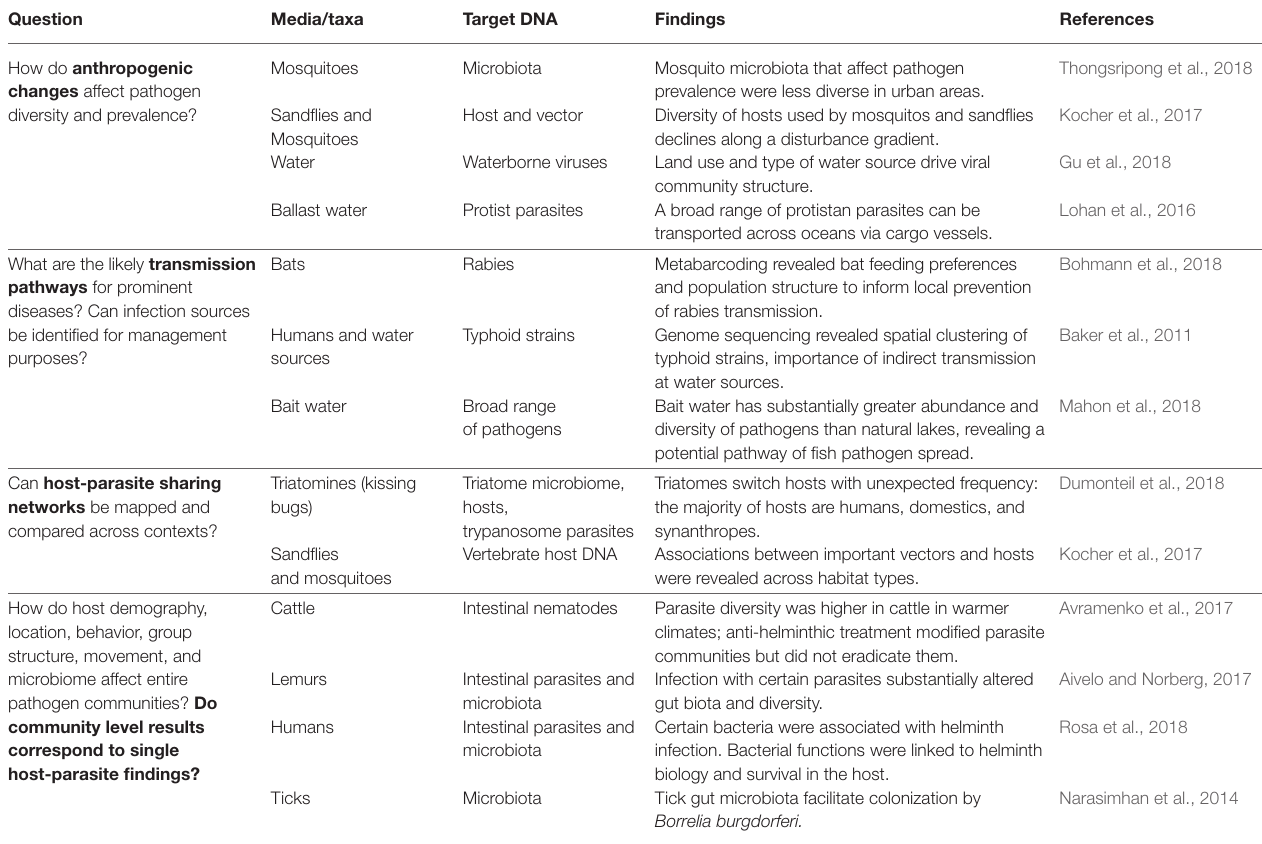
TABLE 1 | Questions in disease ecology that have been addressed with HTS